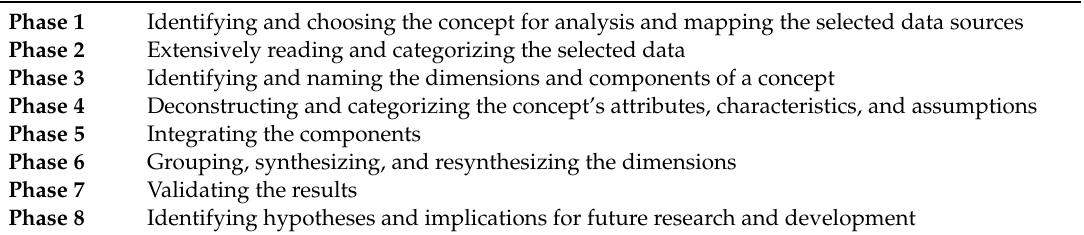
Table 1. Steps in the conceptual analysis (revised approach drawing on Rodgers [11] and Jabareen